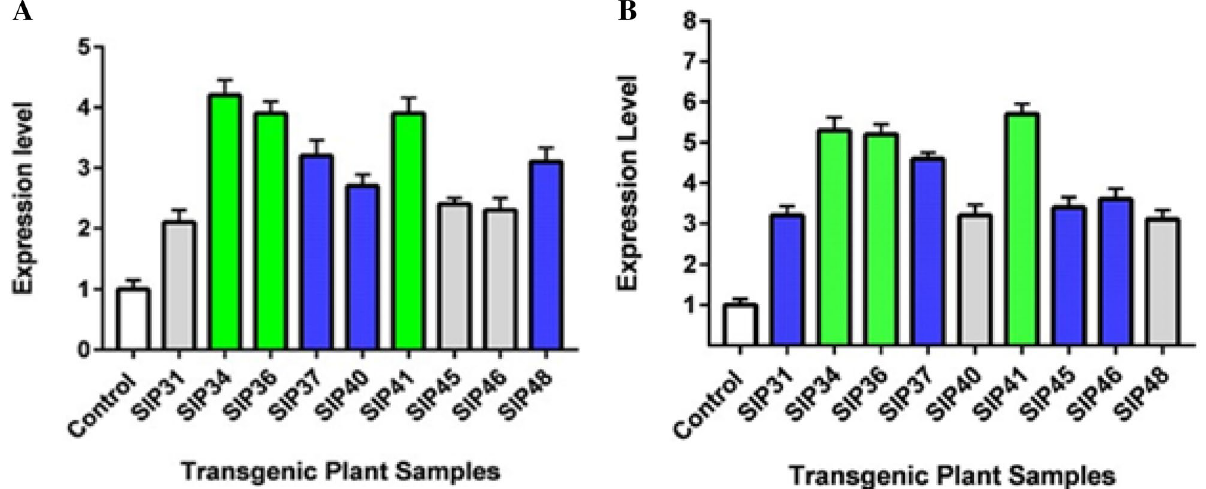
Figure 6. ( A ) Trehalulose synthase geneII ( ThSyGII ) expression levels of PCR positive transgenic lines extracted from leaf tissue samples in contrast to control lines ( B ) ThSyGII expression levels representing PCR positive transgenic lines in from stem tissues contrasting to control lines. Green color transgenic lines manifested highest expression, blue color transgenic lines conveyed medium level ThSyGII expression while grey lines indicated lowest gene expression levels. White colored sugarcane lines showed control non-transgenic lines.